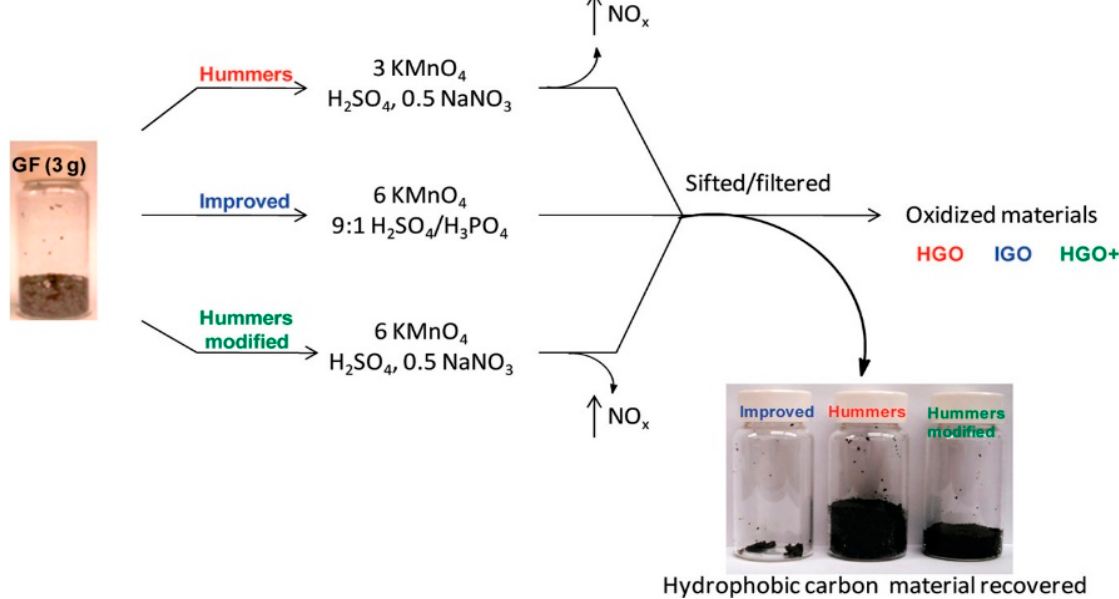
Figure 5. Preparation procedure of improved Hummer’s method of graphene. Reprinted with permission from [56]. Copyright@ ACS publications.